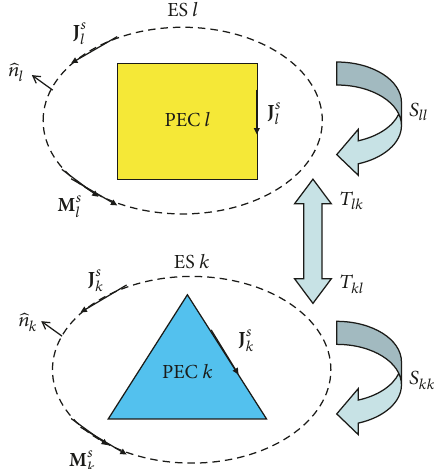
Figure 2: The interaction of two PEC objects using EPA